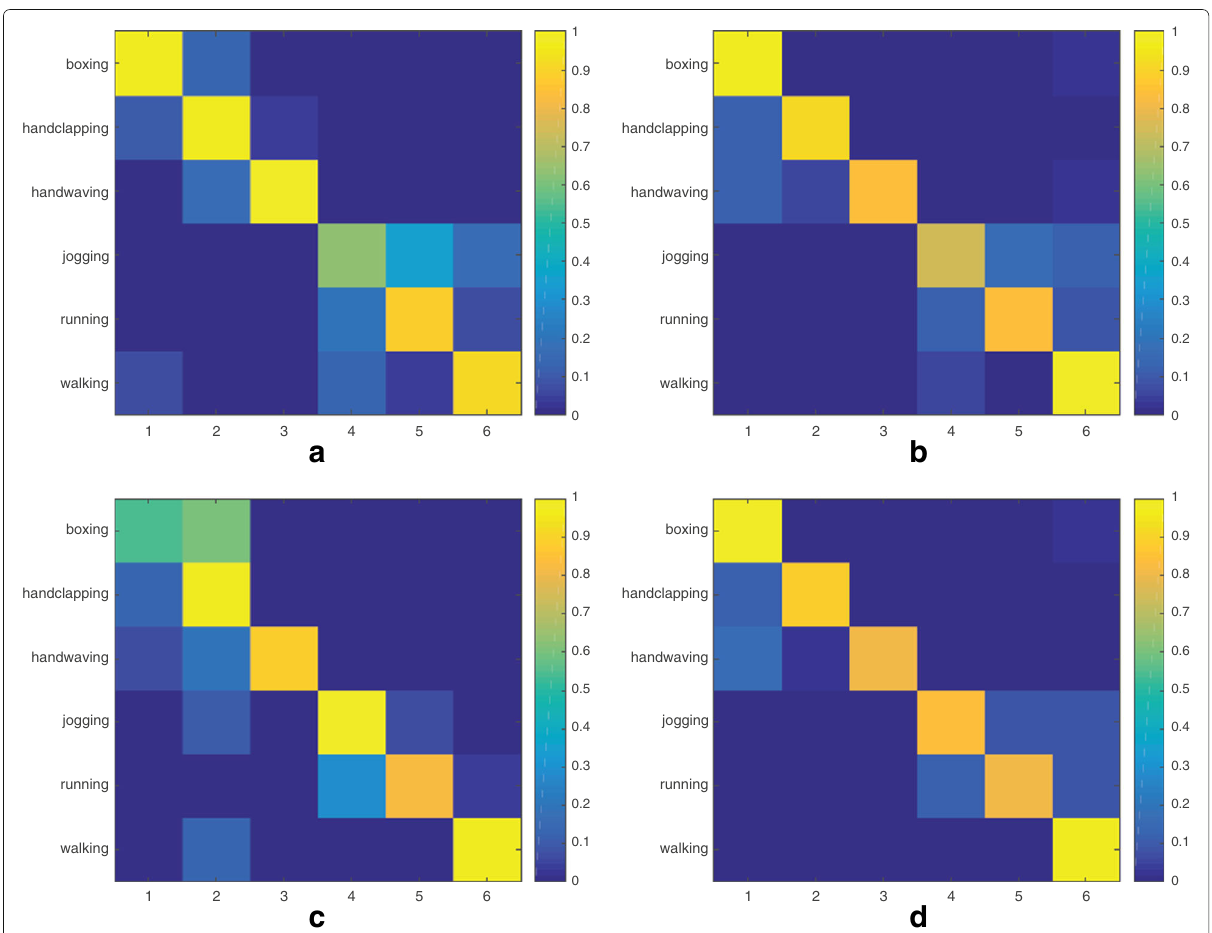
Fig. 7 Confusion matrices of the KTH- SD 3 dataset. Confusion matrices on the right side show the effects of fusing BSIF-TOP textural features with STIP and iDT features. a STIP. b STIP+BSIF-TOP. c iDT. d